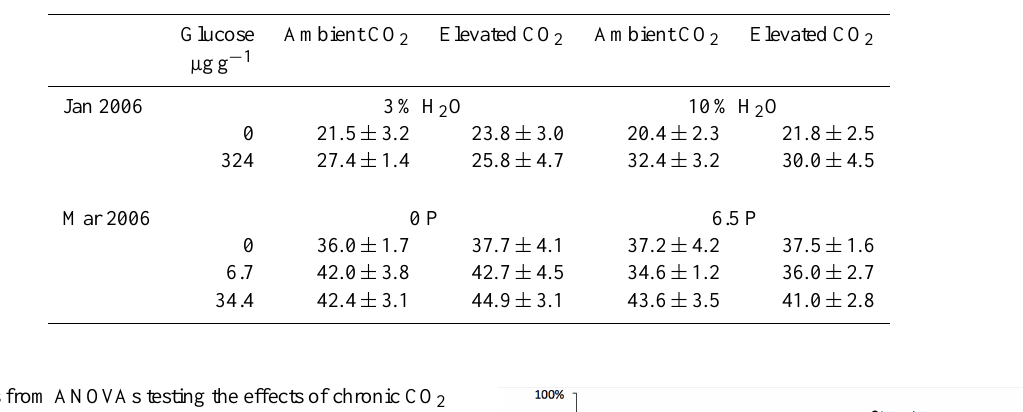
Table 6. P values from ANOVAs testing the effects of chronic CO 2 exposure and short-term additions of glucose, water, and phospho- rus on acetylene reduction. Columns under each date show P val- ues for main effects and interactions tested on that date, H 2 O for January and phosphorus for March (note: the first P value in each column is a main effect).